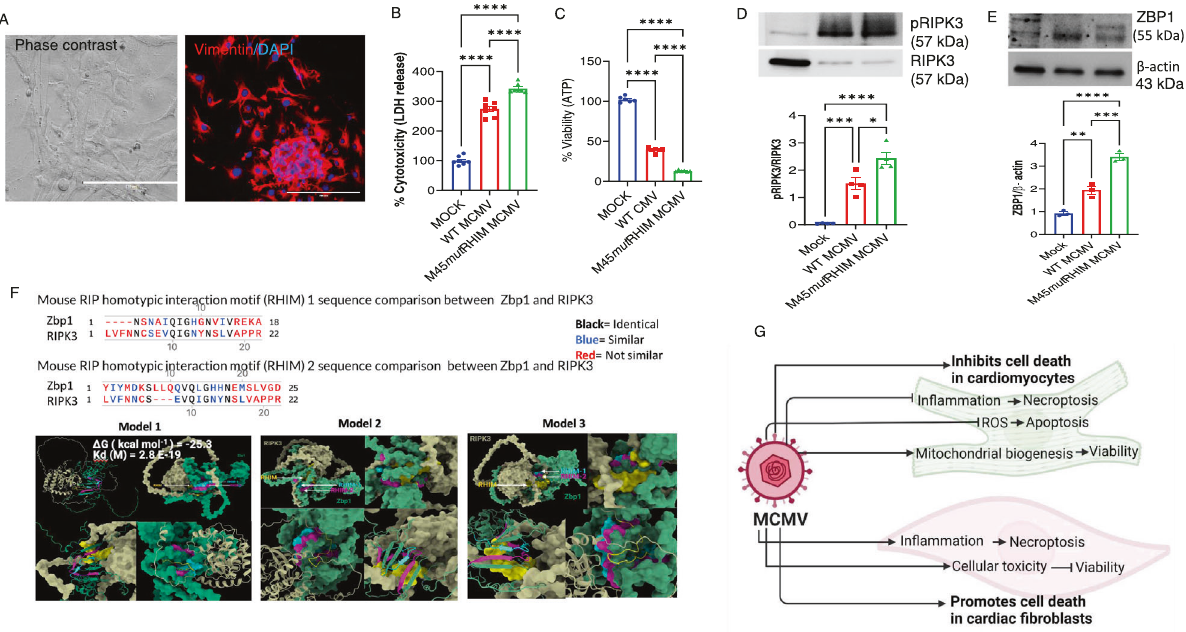
Fig. 4 MCMV infection decreases cell viability by promoting necroptosis and apoptosis in primary cardiac fi broblasts. A Imaging cardiac fi broblasts immuno fl uorescence by Phase-contrast and vimentin. B Cell toxicity measurement by lactate dehydrogenase (LDH) release in uninfected (MOCK), WT MCMV, and M45 mut RHIM MCMV infected cardiac fi broblasts. C Cell viability evaluation by ATP levels in uninfected (MOCK), WT MCMV, and M45 mut RHIM MCMV infected cardiac fi broblasts. D Immunoblot and quanti fi cation of pRIPK3/RIPK3 in cardiac fi broblasts infected with WT and M45 mut RHIM MCMV. E Immunoblot and quanti fi cation of ZBP1 in cardiac fi broblasts infected with WT and M45 mut RHIM MCMV. F ZBP1 and RIP3 protein-protein-interactions in RHIM 1 and RHIM 2 domain. RHIM motif sequences for ZBP1 and RIPK3 were obtained from Uniprot database Q9QY24, Q9QZL0, respectively. Sequences were aligned using SnapGene software using global alignment tool (Needleman – Wunsch), identical amino acids are highlighted in black, similar amino acids in blue, and different amino acids in red. In 3 predicted models for ZBP1 binding to RIPK3, both ZBP1 and RIPK3 structures were obtained from alpha-fold database Q9QY24, Q9QZL0, respectively. Structural docking was performed using ClusPro for Protein-Protein docking. All models were analyzed for